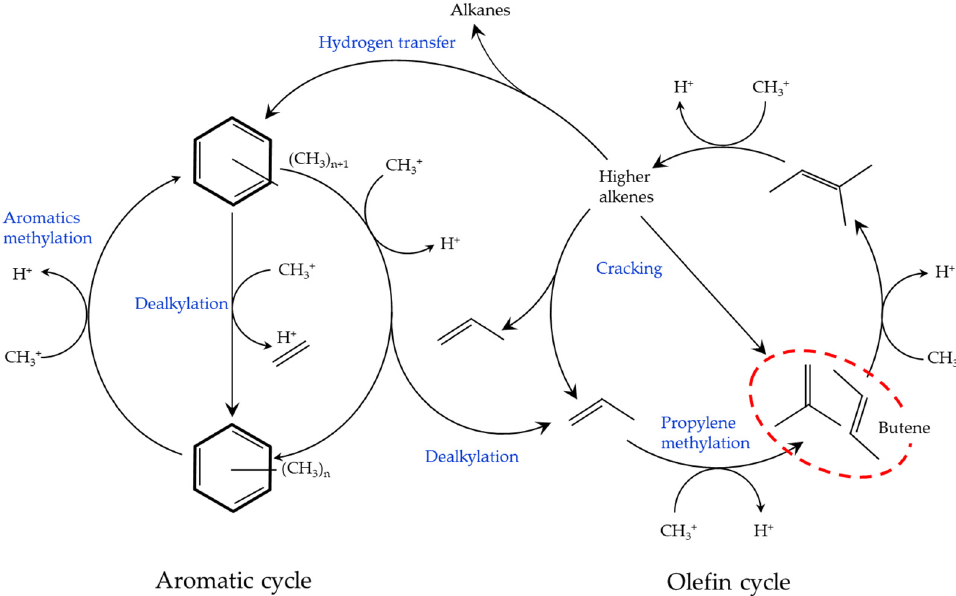
Figure 7. Dual-cycle mechanism. Adapted with permission from Ref. [43]. Copyright 2012, Elsevier. Adapted with permission from Ref. [44]. Copyright 2012, Wiley. Adapted with permission from Ref. [45]. Copyright 2012, American Chemical Society.